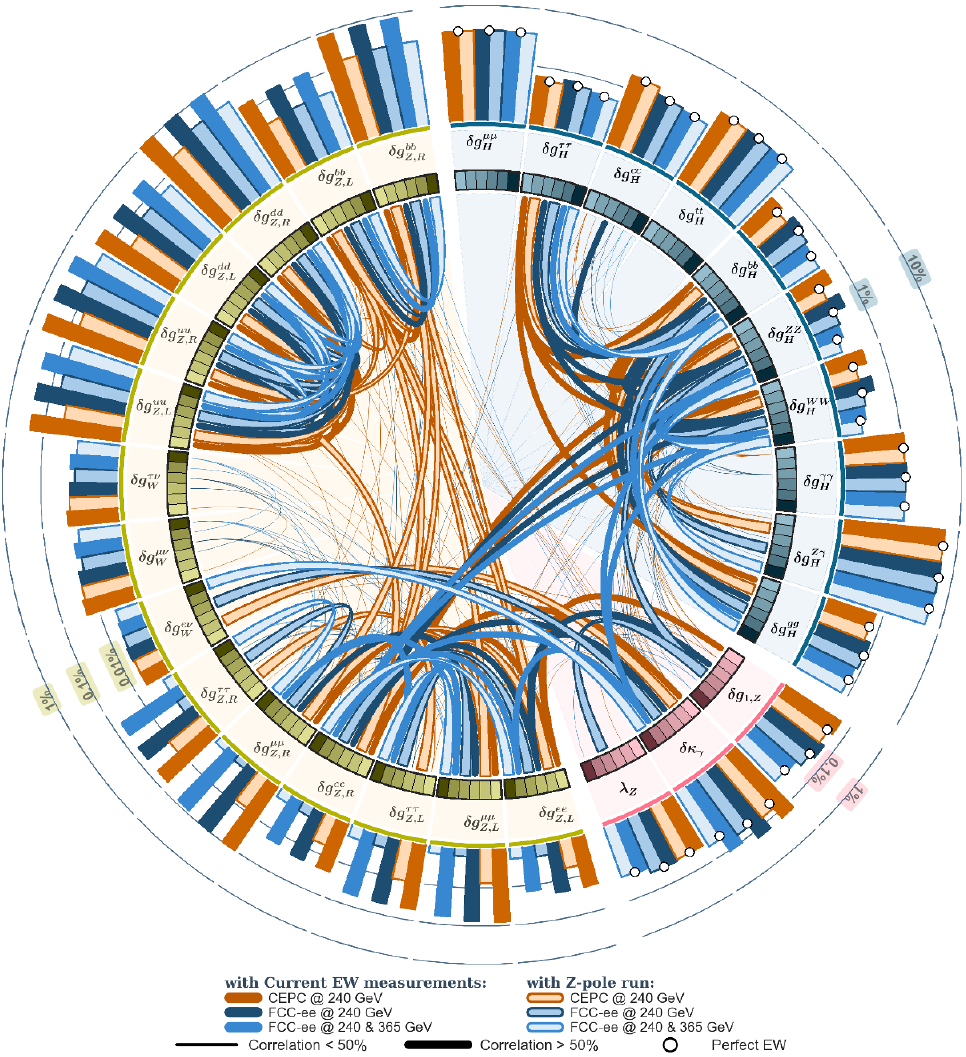
Figure 11 . A scheme-ball illustration of the constraints on and correlations between all the e(cid:11)ective couplings with and without a Z -pole run at CEPC and